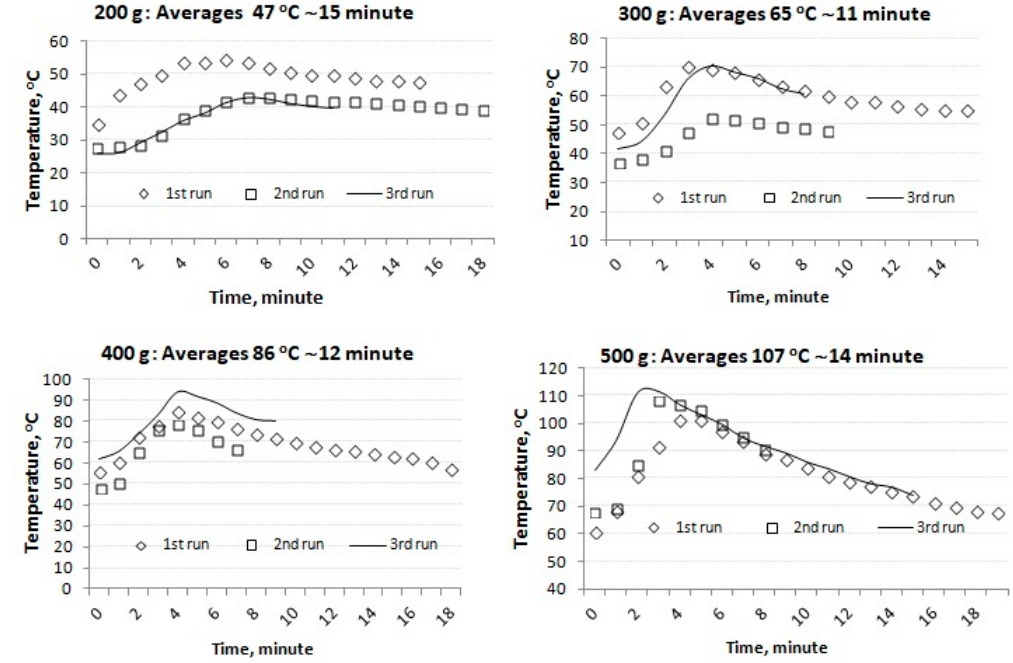
Figure 3. Profile of smoking chamber temperature with 200 g, 300 g, 400 g, and 500 g mass of coconut shell.